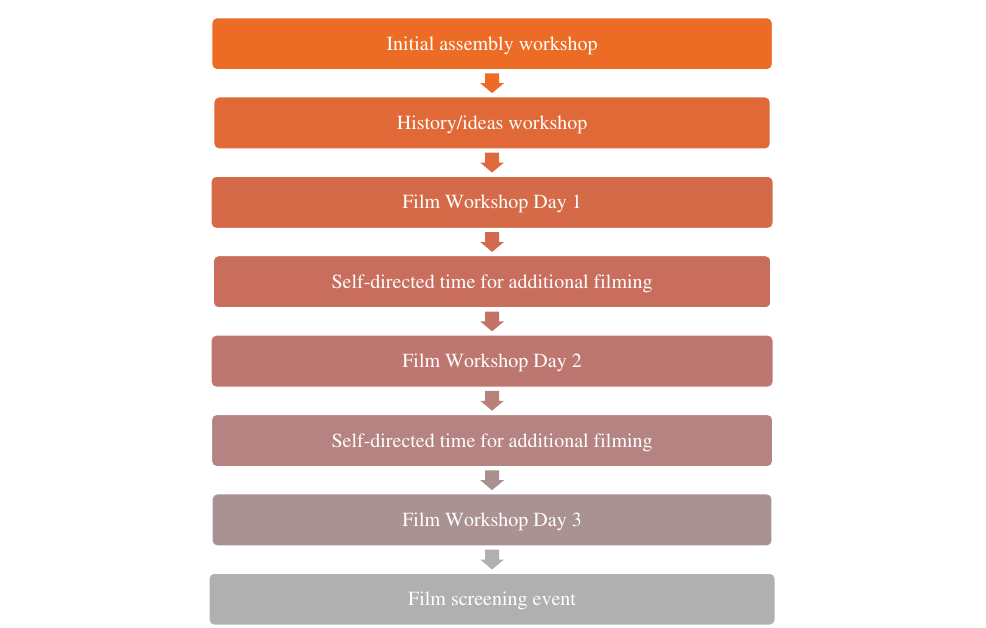
Figure 1: The student journey through the